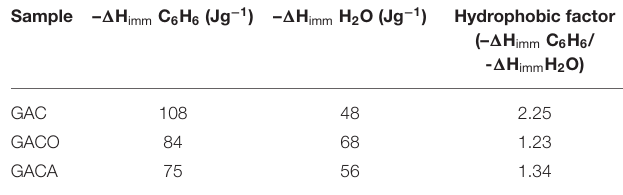
TABLE 5 | Immersion enthalpies in benzene and water for carbonaceous